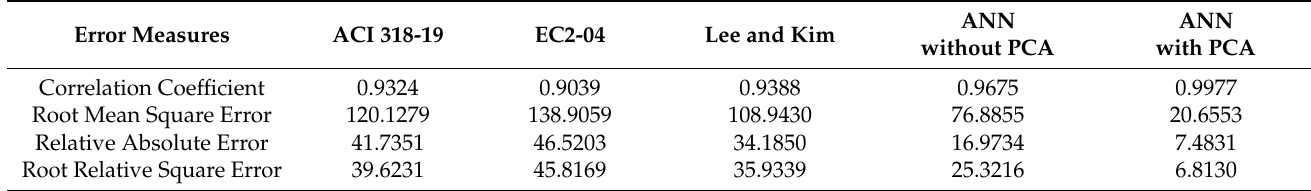
Table 2. Prediction